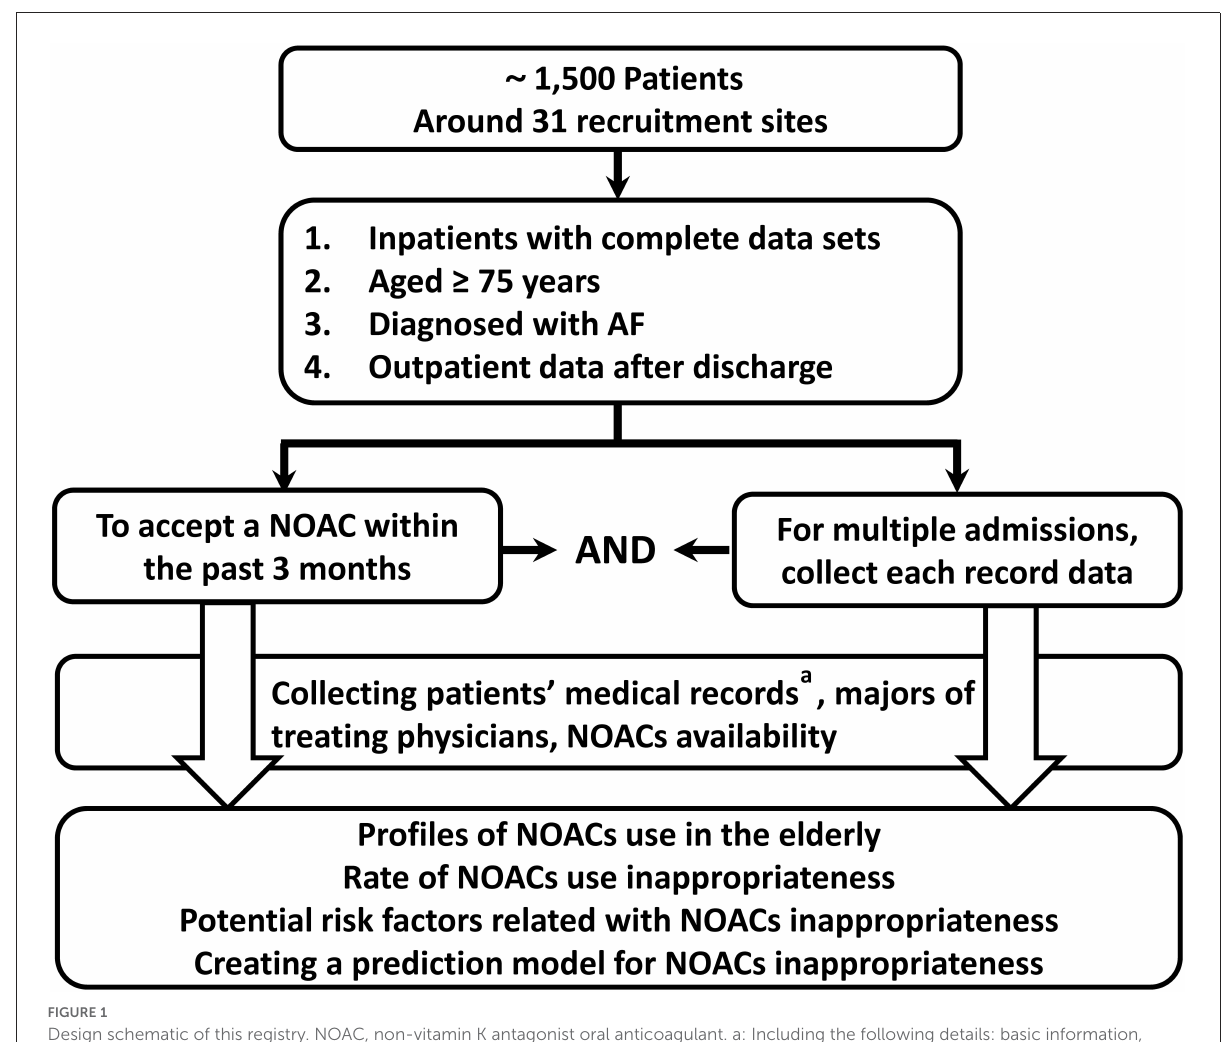
FIGURE1 Design schematic of this registry. NOAC, non-vitamin K antagonist oral anticoagulant. a: Including the following details: basic information, disease information, history, latest laboratory data, co-administrations with NOACs, risk factors for thromboembolism (CHA 2 DS 2 -VASc score), and risk factors for bleeding (HAS-BLED